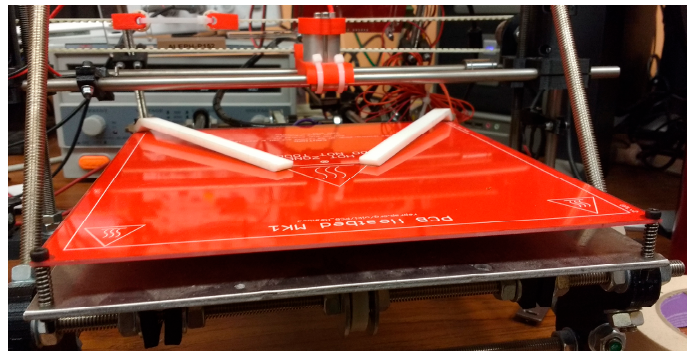
Figure 4. 3-D printer bed fixed with springs and a pair of printed specimen clips (white).